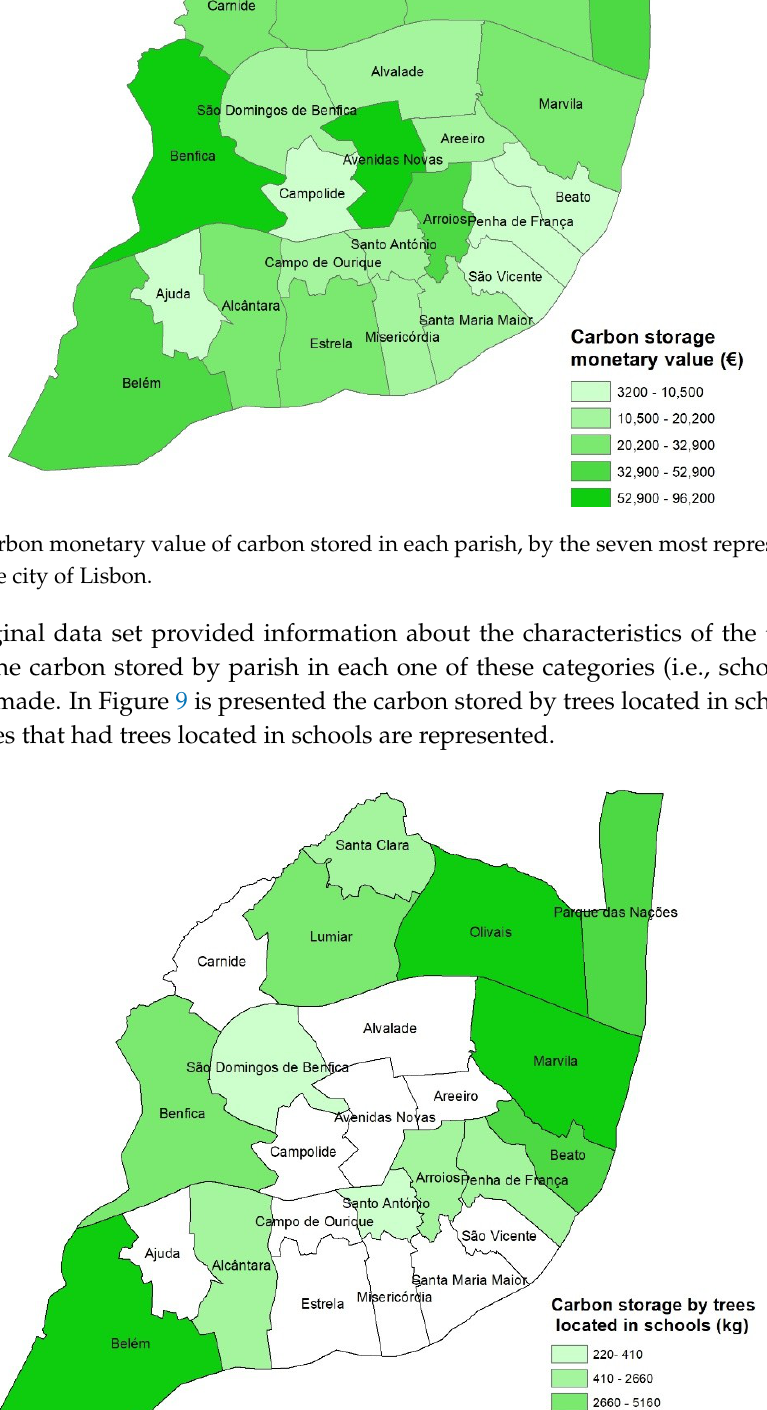
10 of 16 Figure 7. Carbon storage monetary value for each of the tree species in the city of Lisbon. In Figure 8 is presented the carbon monetary value in each parish of the city of Lisbon by the